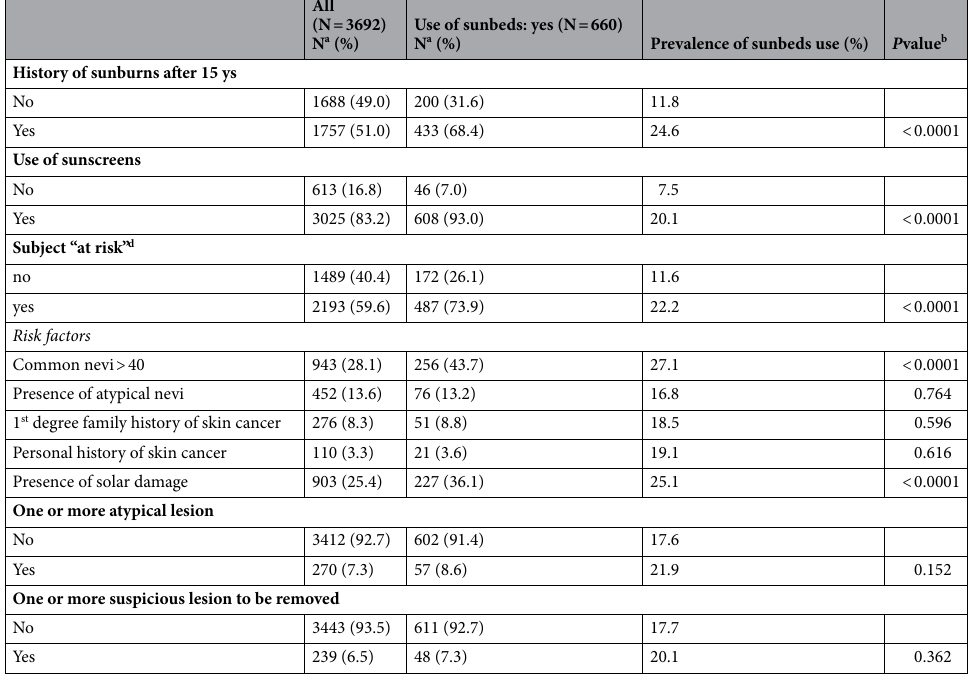
Table 1. Description of the study population and prevalence of sunbeds use according to sociodemographic and clinical characteristics, habits and risk factors. SD standard deviation; IQR , interquartile range. a Totals may vary because of missing values. b χ 2 test. c Mann–Whitney test. d Subjects were defined “at risk” if at least one condition was present among > 40 common nevi, atypical nevi, first degree family history of melanoma or non- melanoma skin cancer, personal history of skin cancer, presence of outcomes from solar damage (i.e. sunburns, solar lentigo